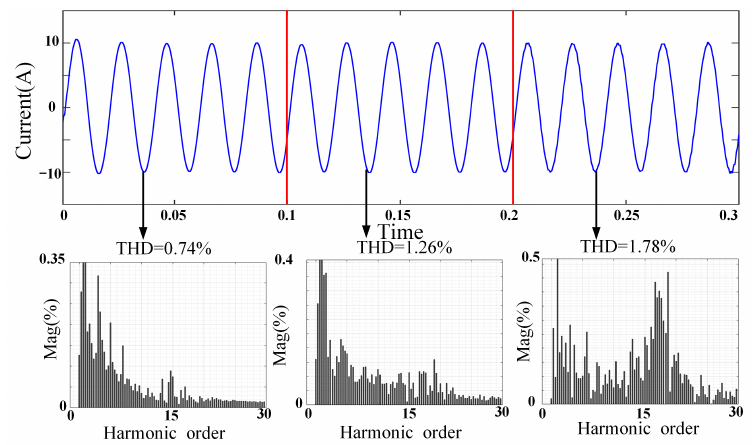
Figure 13. The grid-connected current when filter parameters change and sensor noise is added.